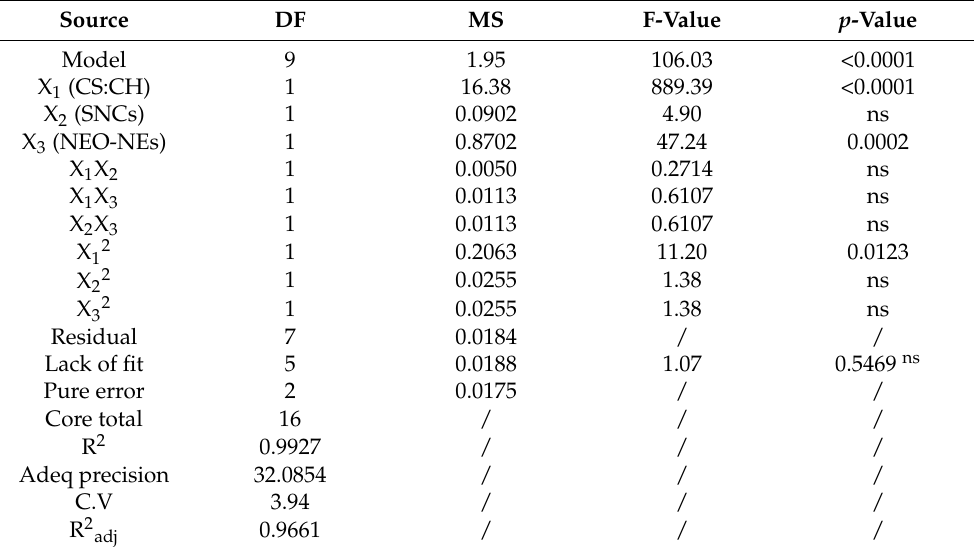
DF, and MS are degree of freedom, and mean squares, respectively. ns: non-significant.